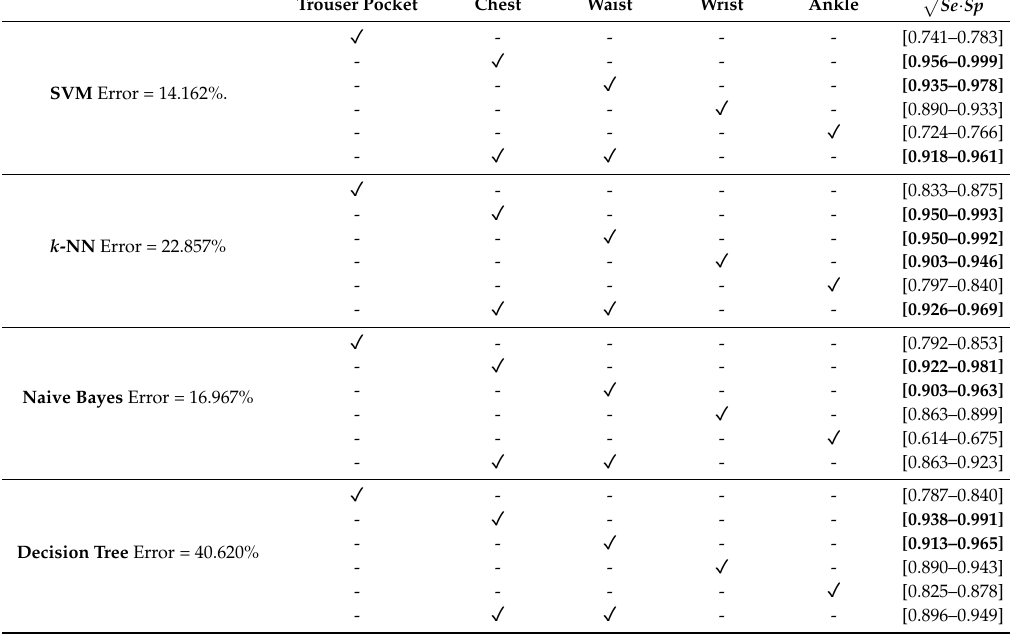
Table 8. Summary of the results of the study on the impact of the sensor position. For every combination, the tick symbol ( ) identifies those sensors that are employed by the algorithm. Trouser Pocket